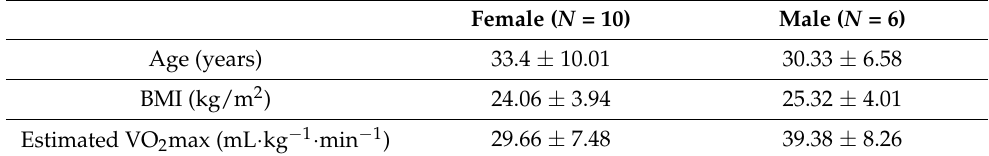
Table 1. Participant Demographics.